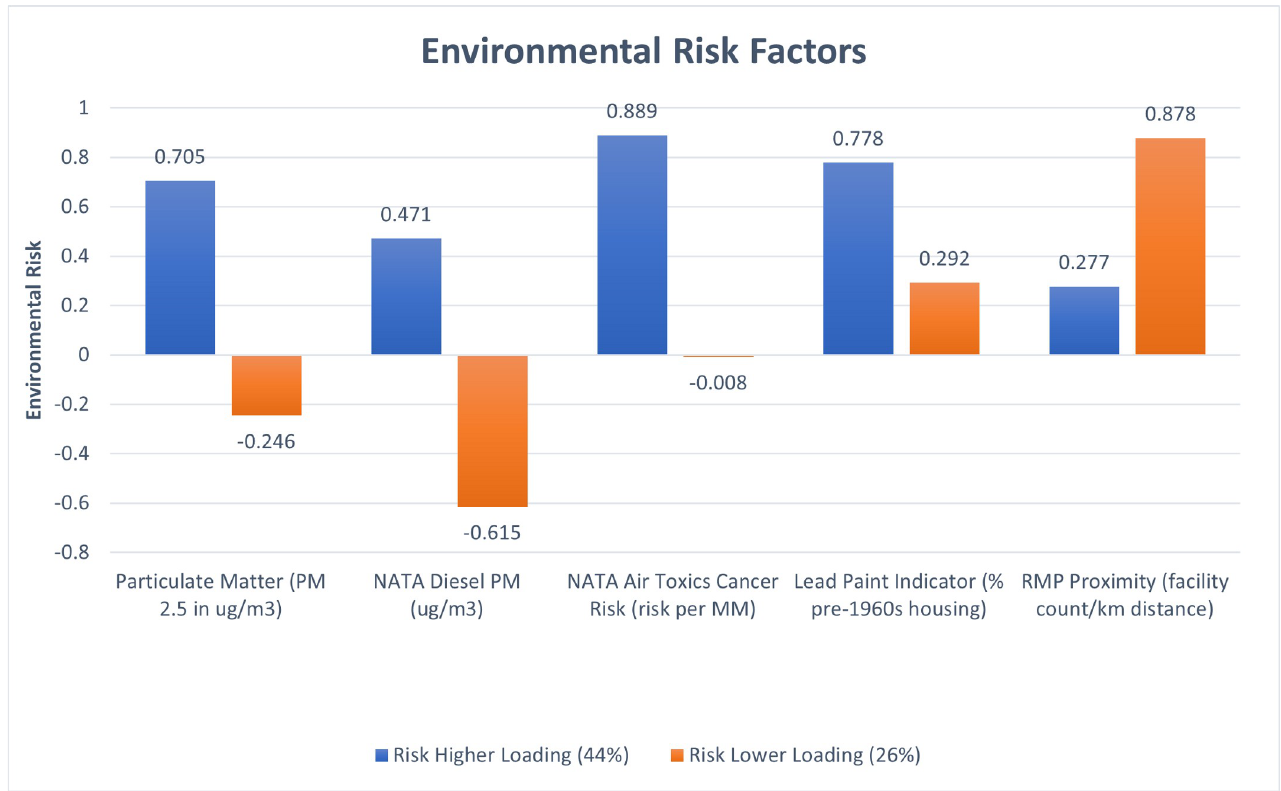
Fig 2. Environmental Risk Factors indicates the environmental factors across the transects likely to represent the greatest combined risk. Higher scores indicate higher risk of environmental exposure.